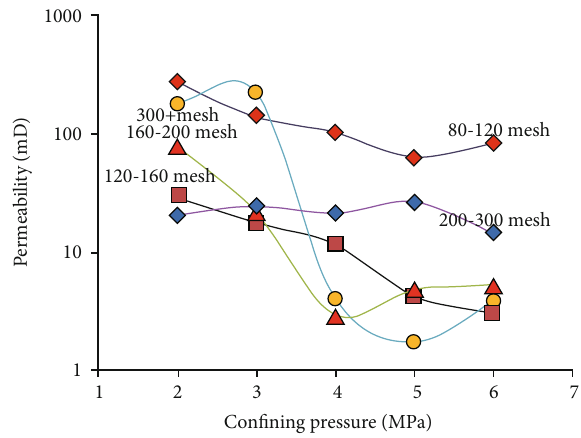
Figure 8: E ff ect of con fi ning pressure and coal fi nes size on permeability.